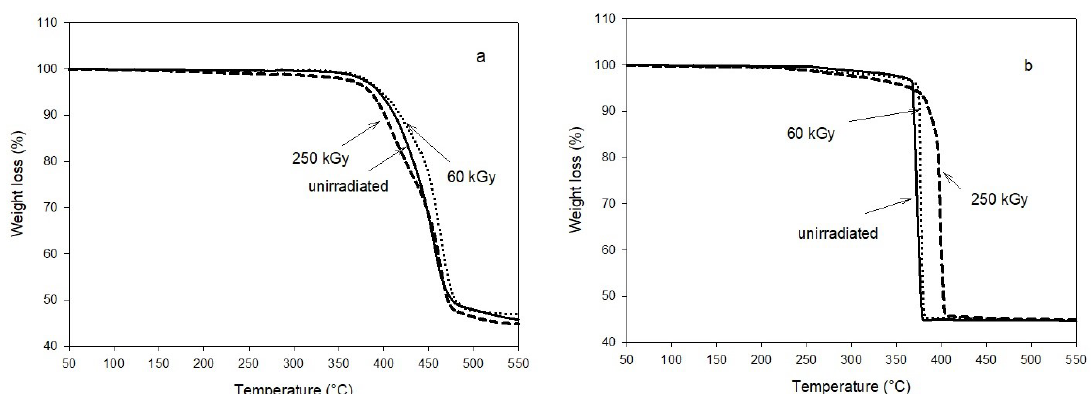
Figure 2. Thermogravimetry analysis (TGA) results for unirradiated and gamma-irradiated green linear low density polyethylene (LLDPE) composite carried out at 10 °C.min -1 heating rate under a) N